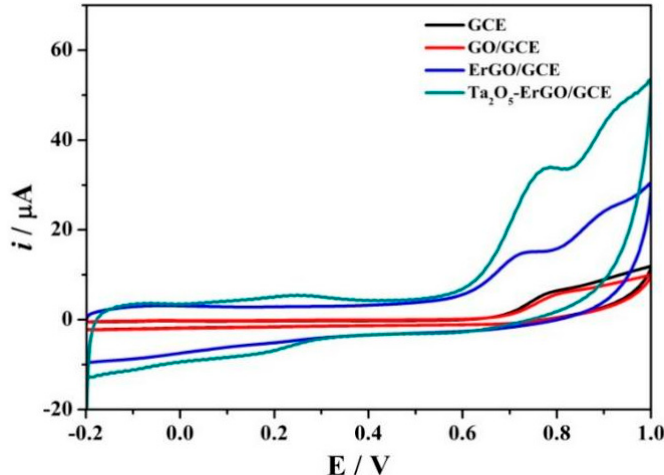
Figure 4. Oxytetracycline (10 μ M) on bare GCE, GO/GCE, ErGO/GCE, and Ta 2 O 5 -ErGO/GCE (cyclic voltammetry, electrolyte: pH = 6.5, phosphate buffer solution (PBS), scan rate: 0.1 V/s).